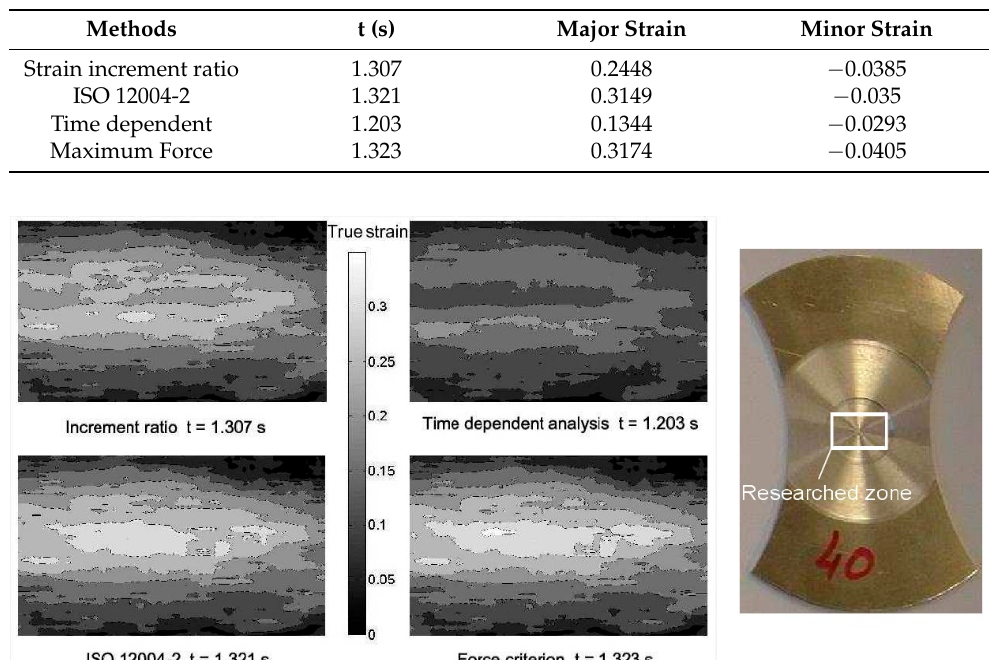
Figure 7. Mises effective strain distribution of the specimen corresponding to different critical times.